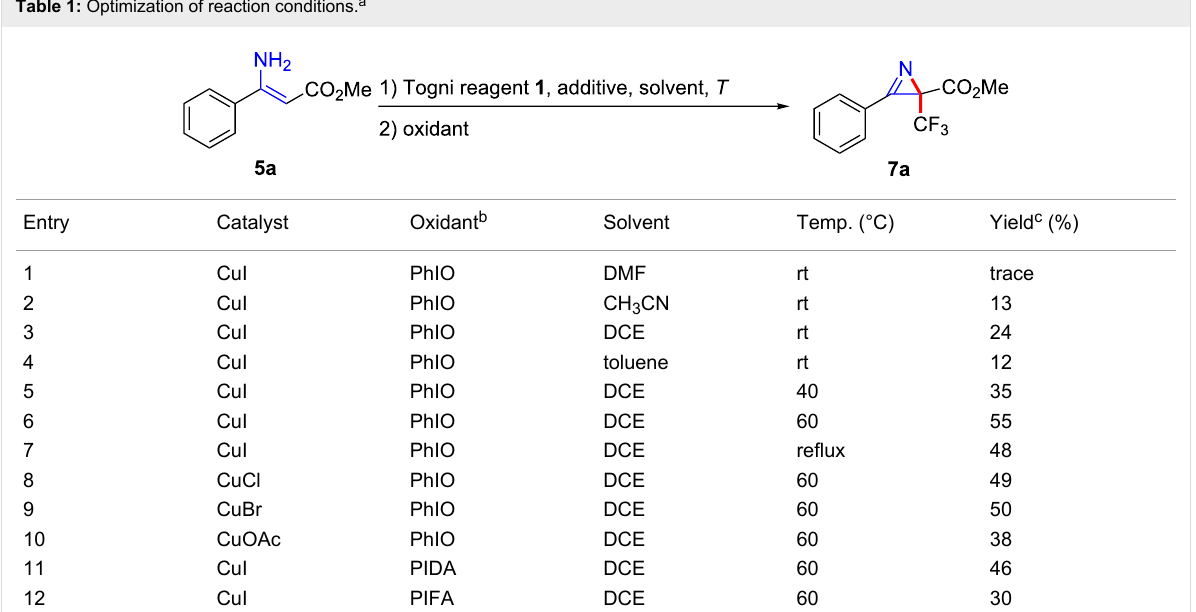
Table 1: Optimization of reaction conditions. a